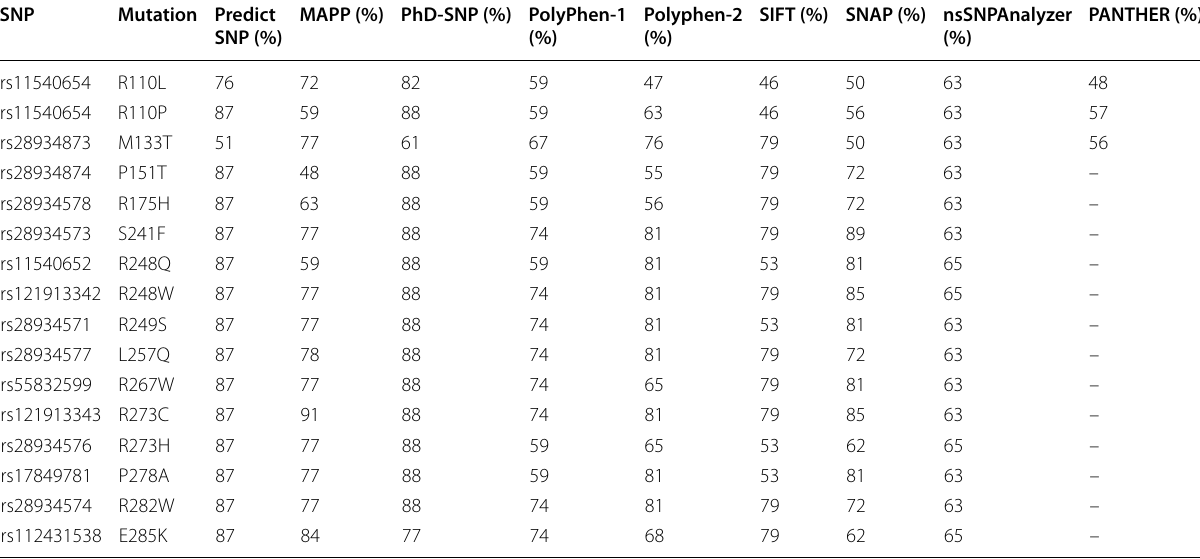
Table 2 Further analysis of 16 SIFT predicted nsSNPs by PredictSNP (online tool) SNP Mutation Predict MAPP (%) PhD‑SNP (%) PolyPhen‑1 SNP (%) (%)